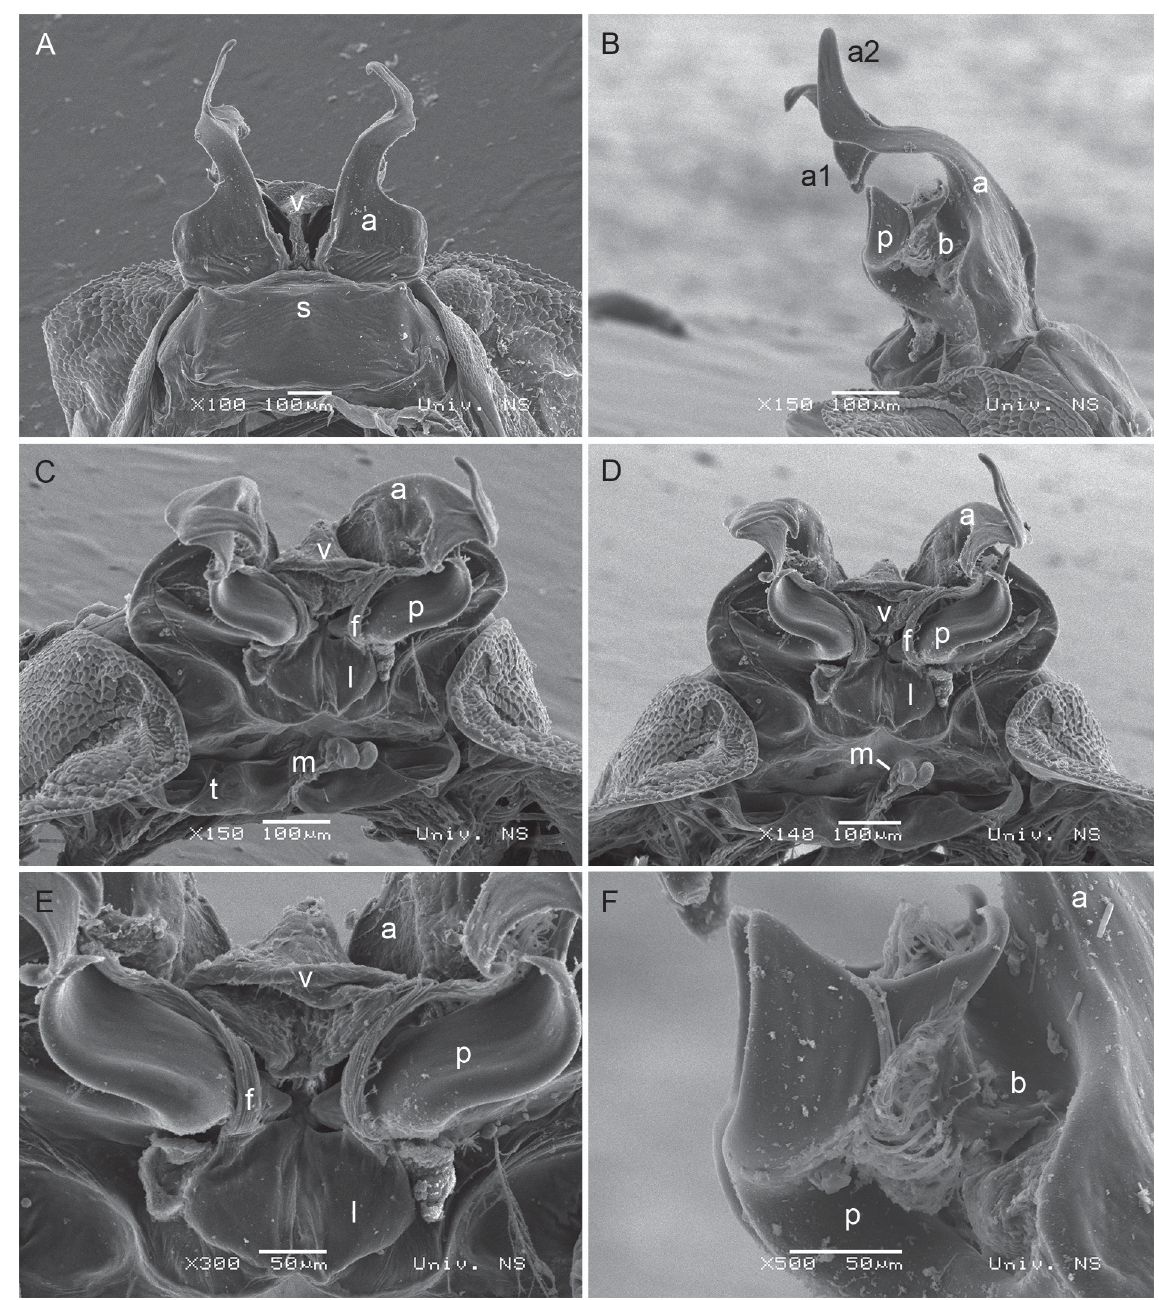
Fig. 2. Biokoviella mauriesi Mršić, 1992, ♂, topotype, gonopods. A . Anterior gonopods, anterior view. B . Anterior gonopods, lateral view. C – D . Anterior and posterior gonopods, postero-distal view. E . Anterior gonopods, postero-distal view of the medial part. F . Anterior gonopods, lateral view of the posterior process and bristle apparatus. Abbreviations: see Material and